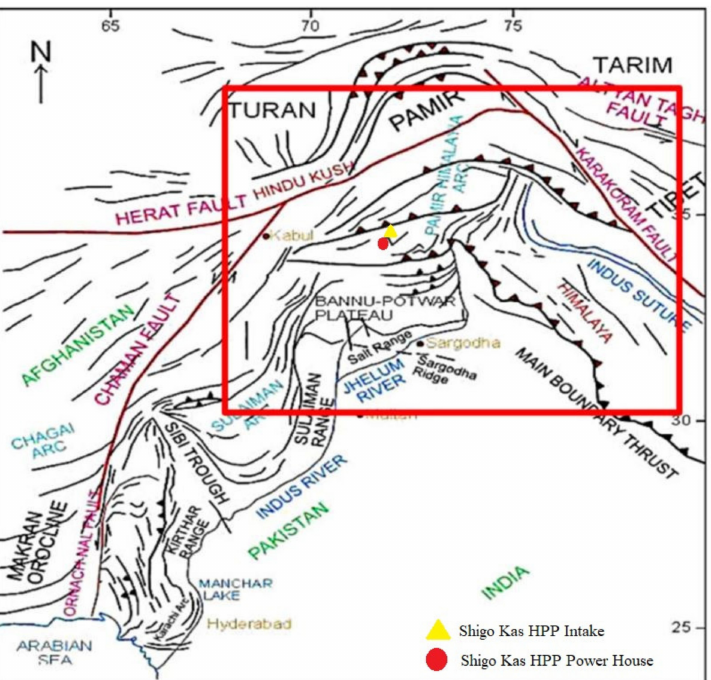
Figure 2. General tectonic setting of Pakistan (courtesy: Geological Survey of